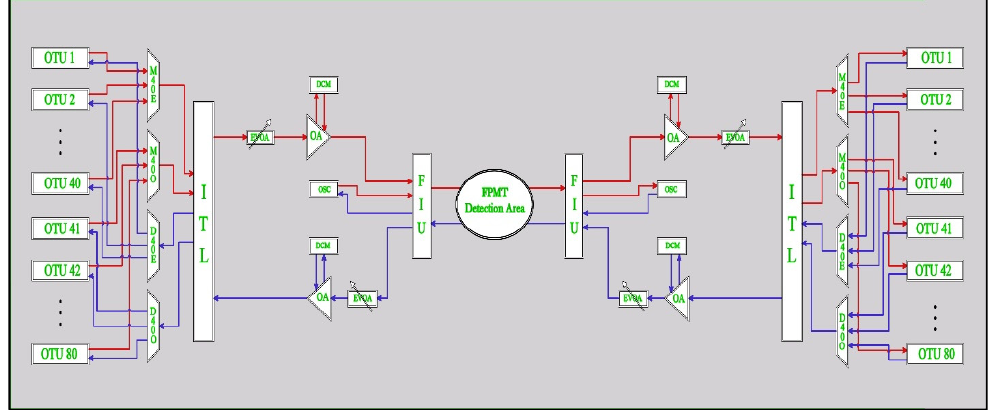
Figure 2. FPMT detection area over the implemented DWDM system.